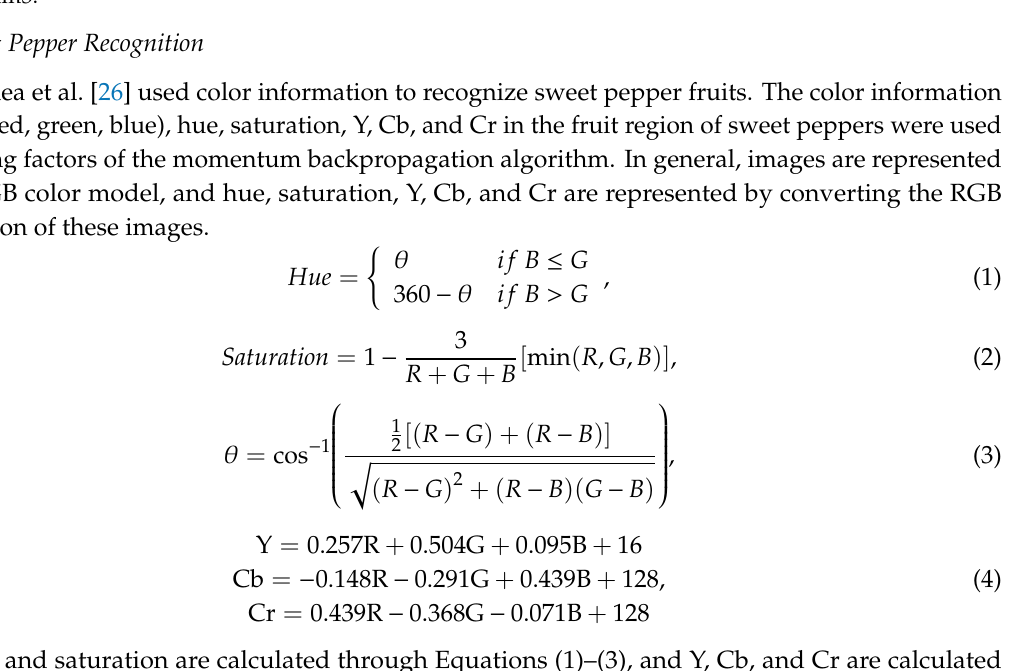
Figure 8. The stereo vision system (Cam1 and Cam2) attached laser source and end-effector attached to Cam3.